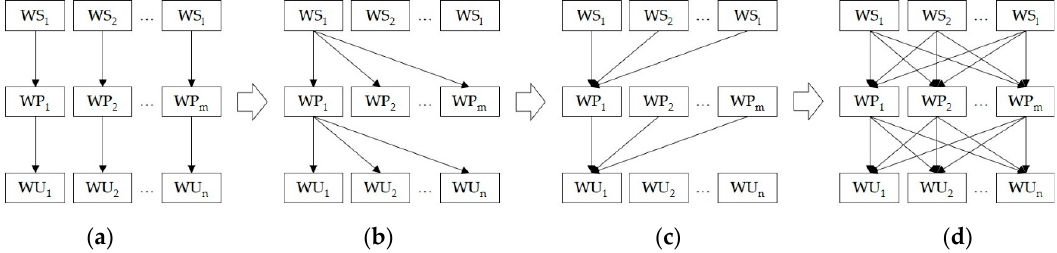
Figure 4. Four urban multi-source water supply modes are as follows: ( a ) one to one; ( b ) one to many; ( c ) many to one; ( d ) many to many (Note: WU, WP WU mean water source, water plant, water user, respectively. l, m, n mean numbers of water source, water plant, water user, respectively).